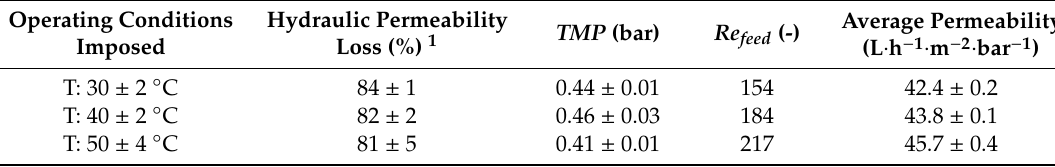
Table 2. E ff ect of the temperature on the purification of the (diluted) arabinoxylans fraction by dia-ultrafiltration operated without relaxation procedure and under controlled